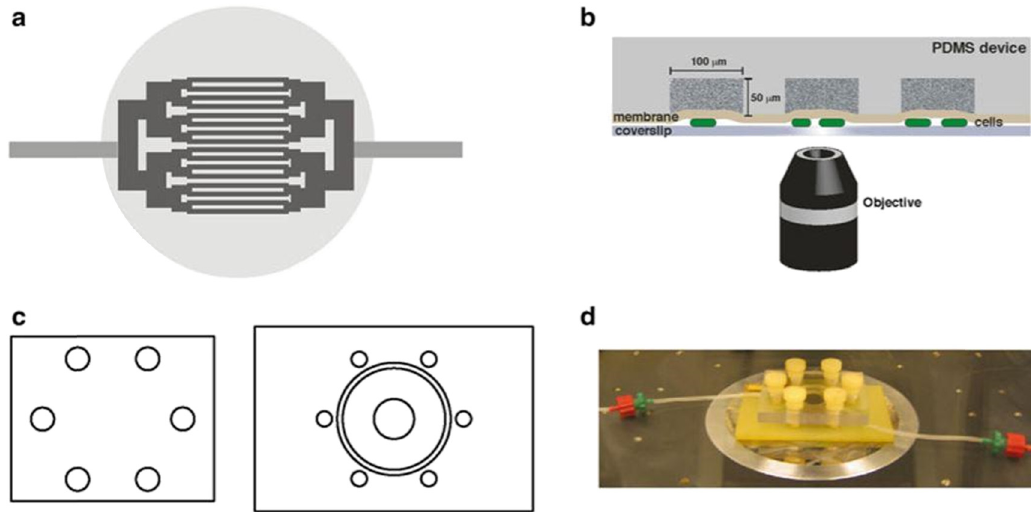
Figure 5: Representation of the PDMS micro fl uidic device presented in ref. [ 41 ] . ( a ) Top view of the microdevice, depicting the channel layout and the inlets and outlets. ( b ) Cross section of the setup for its visualization. The cells get trapped between the coverslip and a semi - permeable membrane for media to di ff use from the channels. ( c ) Acrylic frames of the clamp system, fi xed with screws. ( d ) Picture of the device, once assembled. Image reproduced with permission from Methods in Molecular Biology [ 41 ] .